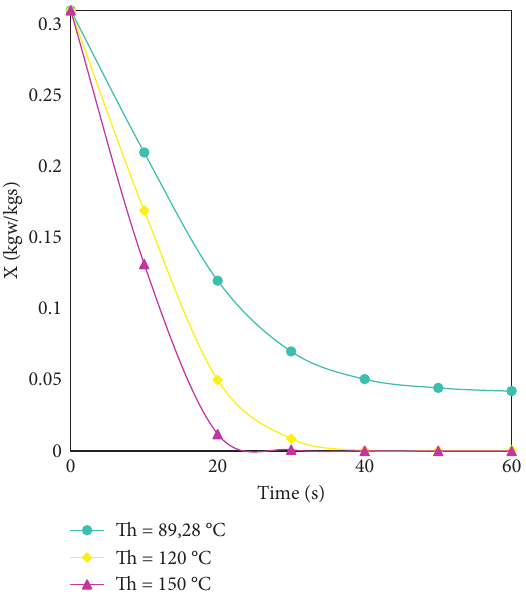
Figure 5: Variation of average adsorbed amount with time for different T